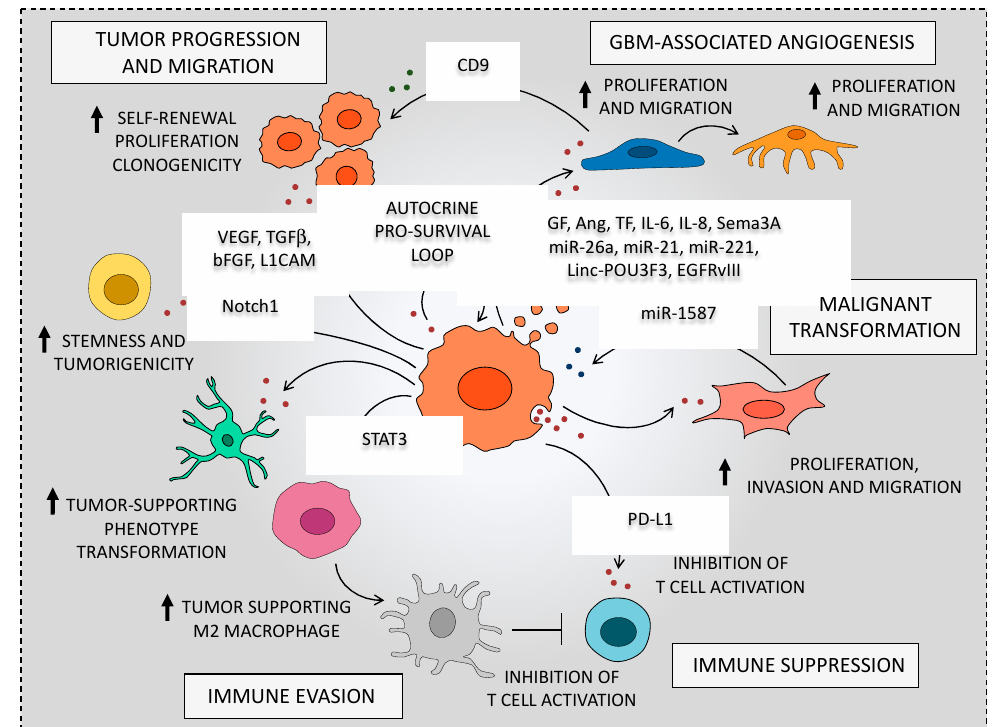
Figure 2. Glioblastoma-derived extracellular vesicles can actively remodel the tumor microenvironment. The cartoon summarizes the major e ff ects of glioblastoma-derived extracellular vesicles (EVs) on cells from the tumor microenvironment. Messages carried in exosomes, such as proteins, RNA and miRNAs, can be taken up by TME recipient cells to elicit a phenotype modulation towards a tumor-supporting phenotype. For instance, GBM-derived exosomes have shown to modulate endothelial cells and pericytes, thus promoting tumor angiogenesis. Again, GSC-derived EVs recruit immune cells (monocytes, macrophages, T cells) to drive immune modulation that fosters tumor growth. Moreover, EVs can be released within the extracellular milieu just close to the perivascular niche thus acting as autocrine factors to promote GSC self-renewal and proliferation. Therefore, EVs can be employed both in autocrine and paracrine modes by GSCs to give a remarkable support to GBM survival and malignant progression.